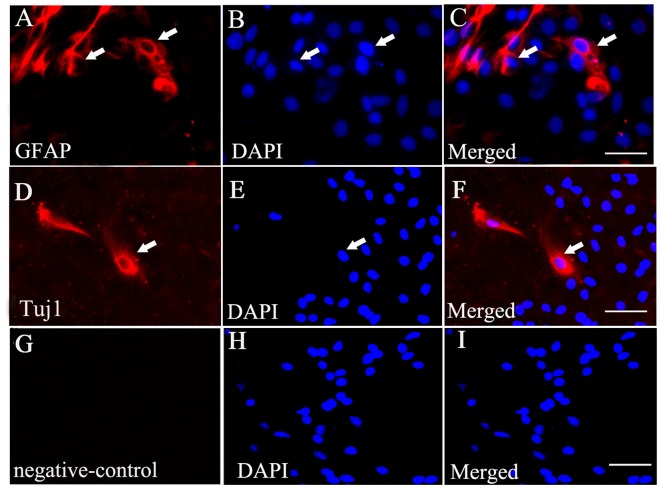
BMSCs could differentiate into neurons and astrocytes when cultured in vitro. (A) Immunofluorescent staining of glial fibrillary acidic portein (GFAP) that exhibits red fluorescence in the cultured BMSCs. (D) Immunofluorescent staining of Tuj1 showing red fluorescence in the cultured BMSCs. (B,E,H) Cell nucleus was stained by DAPI, with blue fluorescence. The merged images showed BMSC may have ability to differentiate into neurons (F) and astrocytes (C) under the 10% FBS condition. (G,I) Negative control (no primary antibody) showed no positive red staining, and there is only DAPI positive staining (blue). White arrows showed the positive cells. Bar = 50 μm. GFAP, glial fibrillary acidic protein; Tuj1, Neuronal Class III β-Tubulin.